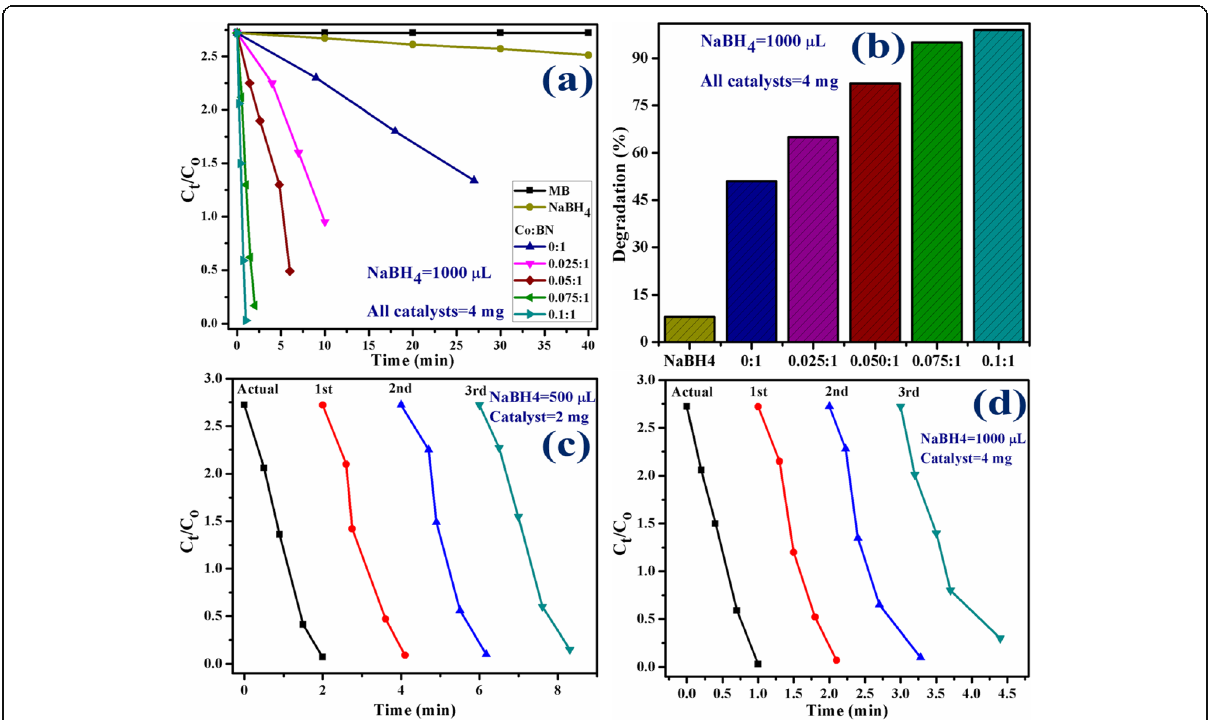
Fig. 11 a Plots of C t / C o versus time using NaBH 4 = 1000 μ L and catalysts = 4 mg. b Comparison of degradation percentage over various concentrations. c Plots of C t / C o versus time for reusability of 10 wt% Co-doped BN-NS. d Plots of C t / C o versus time for reusability of 10